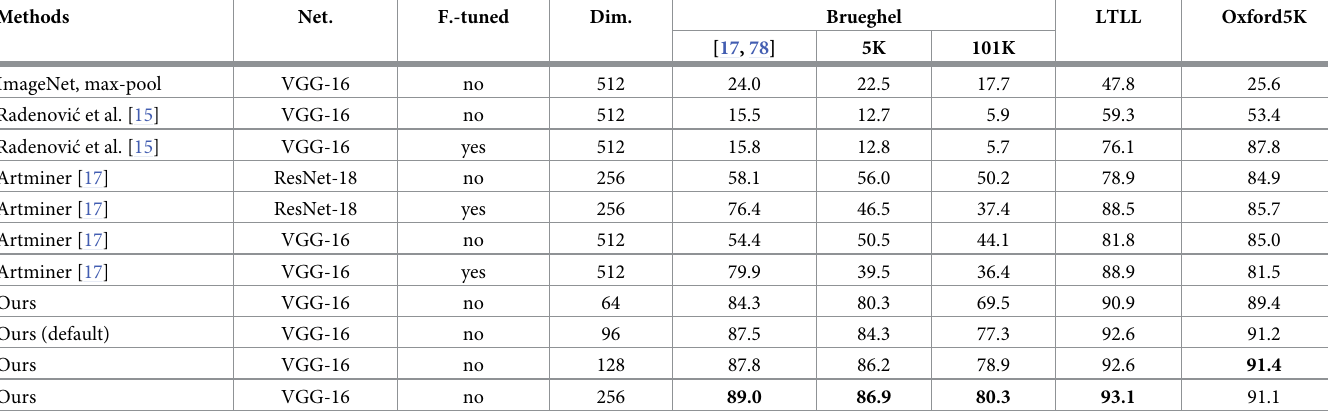
The retrieval performance of our method (Ours), max-pooled features, and state-of-the-art methods on benchmark datasets. We also provide information on the network architecture (Net.), whether or not features are fine-tuned on the retrieval task (F.-tuned), and the utilized feature dimensions (Dim).